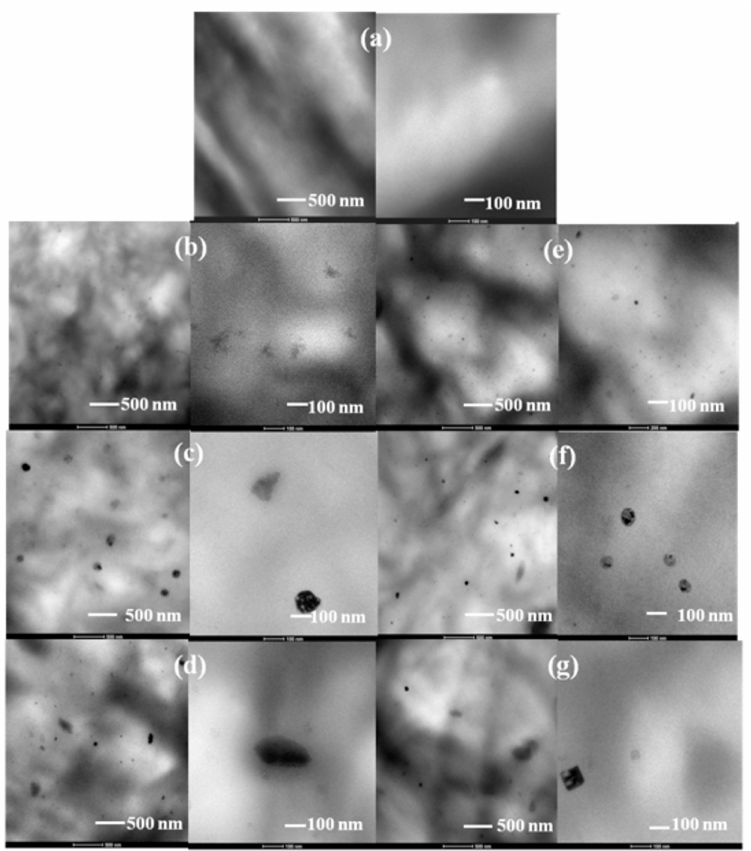
Figure 6. TEM micrographs of melt mixed PCL/POSS nanocomposites: ( a ) PCL; ( b ) PCL/APIBPOSS-2; ( c ) PCL/APIBPOSS-5; ( d ) PCL/APIBPOSS-10; ( e ) PCL/APIOPOSS-2; ( f ) PCL/APIOPOSS-5; ( g )